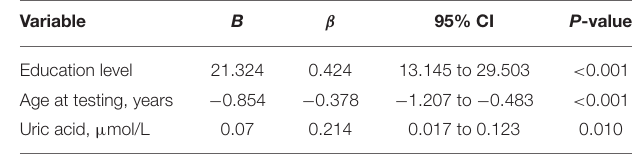
TABLE 2 | The relationship between plasma uric acid and cognitive domains. TABLE 3 | Multivariate model of the total ECAS